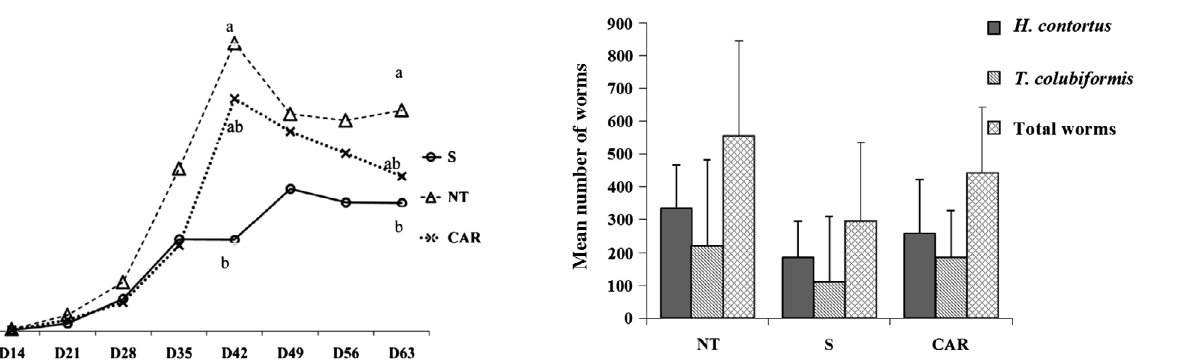
Figure 3. Mean number of worms of the two nematode species recovered and of the total worm number in the different experi- mental groups. S (sainfoin), NT (non-treated/positive control), CAR (carob).